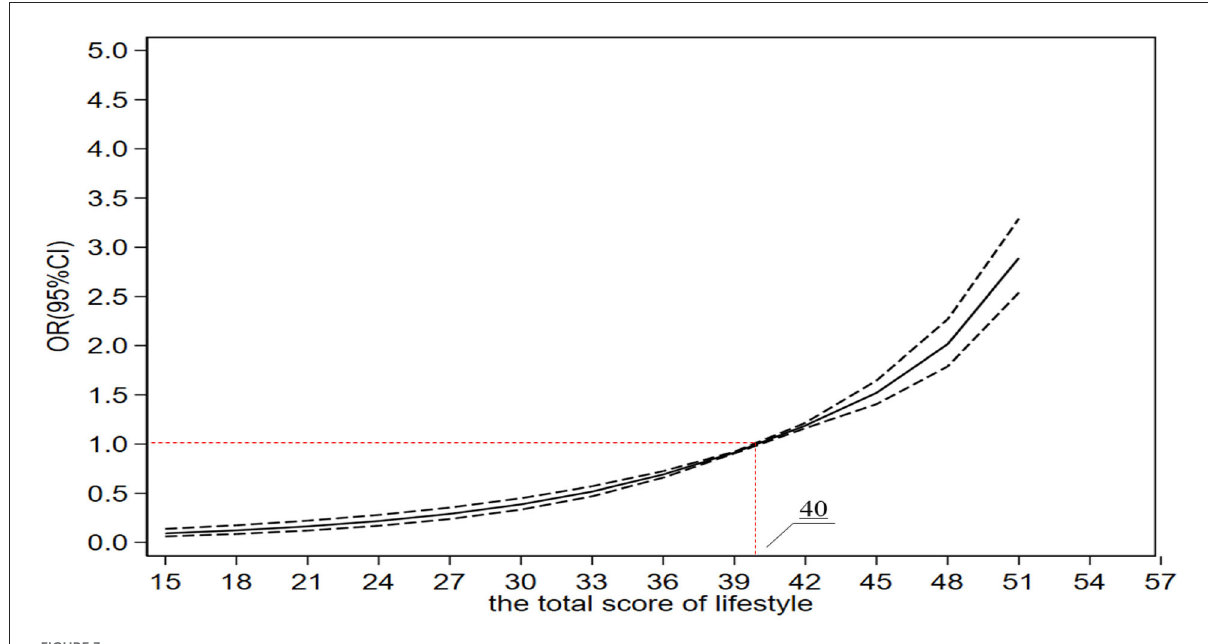
FIGURE3 The association between lifestyle score and the COVID-19